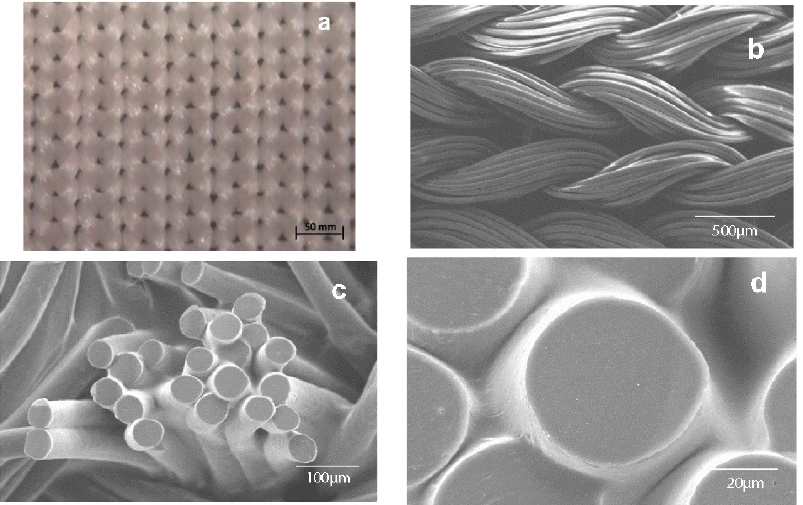
Figure 16. Morphology of PBS knitted constructs showing different levels of detail: Macroscopic image ( a ); top view ( b ) and fibre cross-sections ( c , d ). Reproduced from Almeida et al. [209], copyright (2013), by permission of Elsevier Science